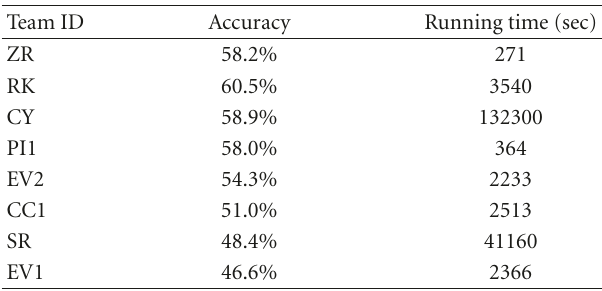
Table 4: F-Measures of proposed method with/without applying relative spectra.